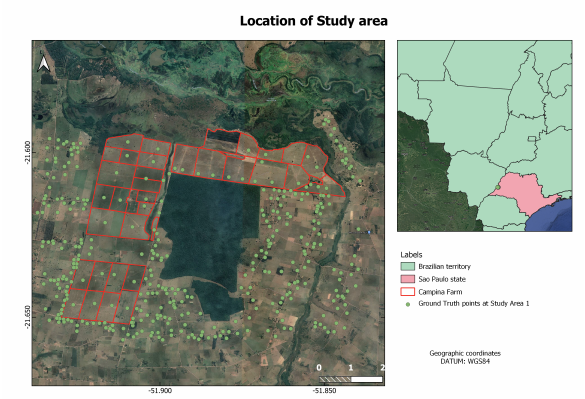
Figure 1. Location of study area and collected ground truth points in Caiu´a municipallity, Sao Paulo state, Brazil.